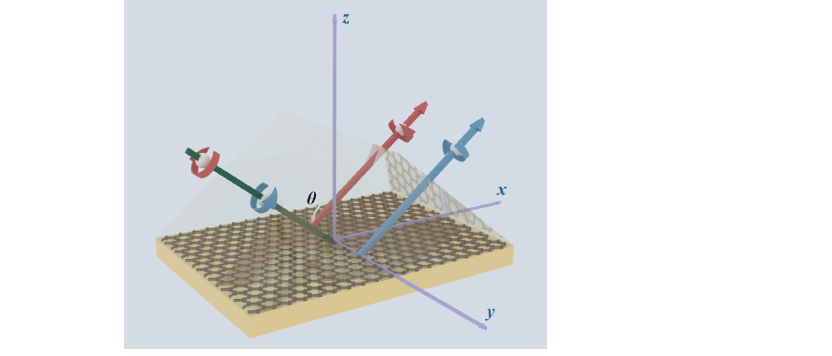
Figure 1. Schematic of prism-coupled monolayer graphene–gold structure and representation of SHEL shift.